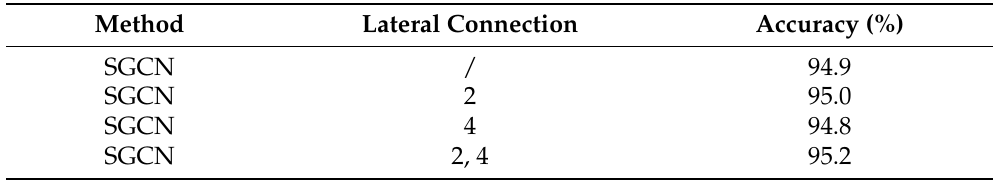
Table 2. Comparisons of validation accuracy of the model with the different lateral connections. The number i in the second column means the model has a lateral connection from i th layer to the fully connected layer.